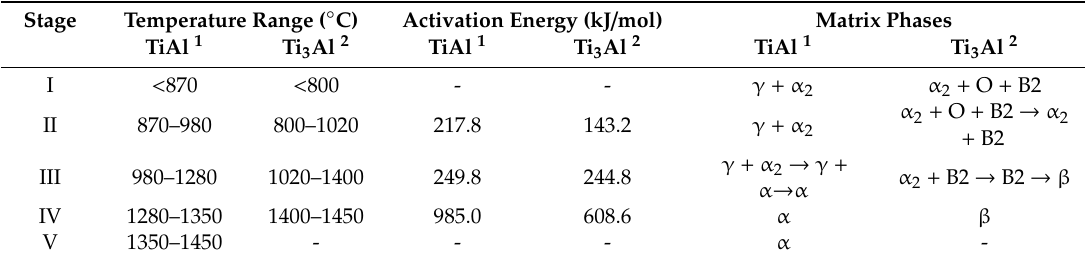
Table 1. Temperature ranges, oxidation activation energies and matrix phases corresponding to different stages of the non-isothermal oxidation for the Ti-46Al-2Cr-5Nb and Ti-24Al-15Nb-1.5Mo alloys.